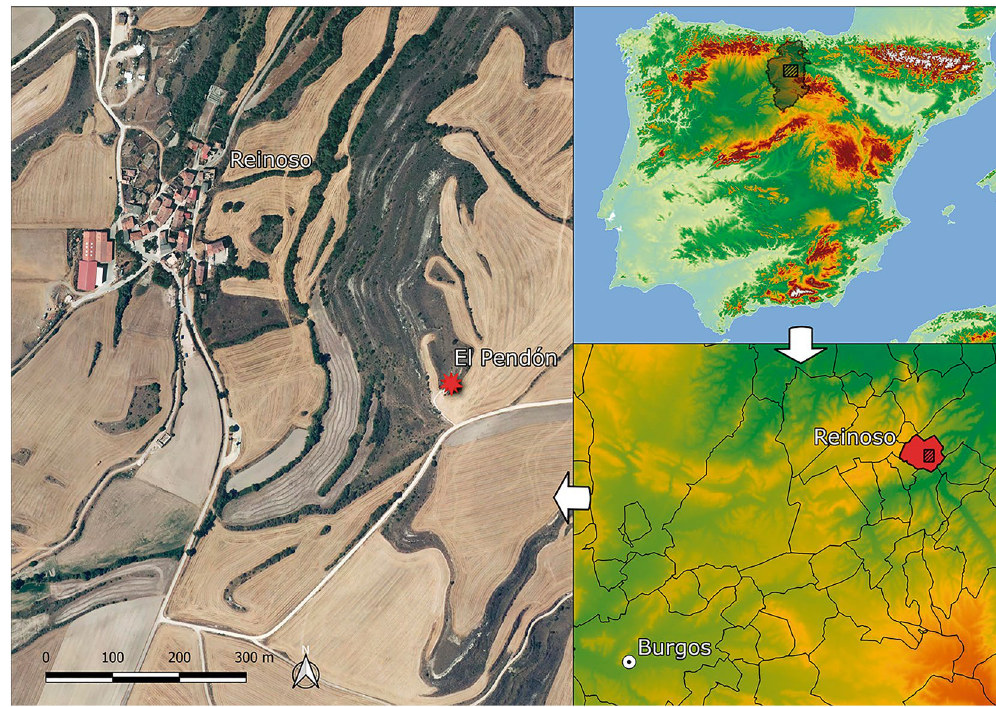
Figure 1. Map of the province of Burgos in the Iberian Peninsula and of the village of Reinoso and the Dolmen of El Pendón in its closest geographical context. The maps and the orthophoto were processed using the open software QGIS v.3.16 Hannover (available online https:// www. qgis. org/ es/